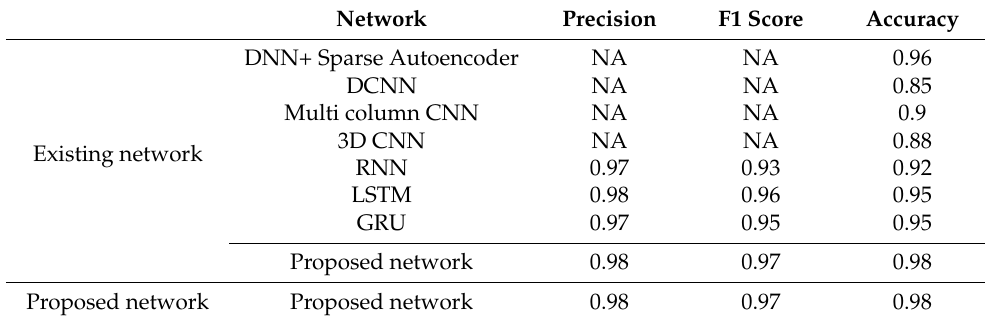
Table 5. Comparative analysis of performance metrics [33].